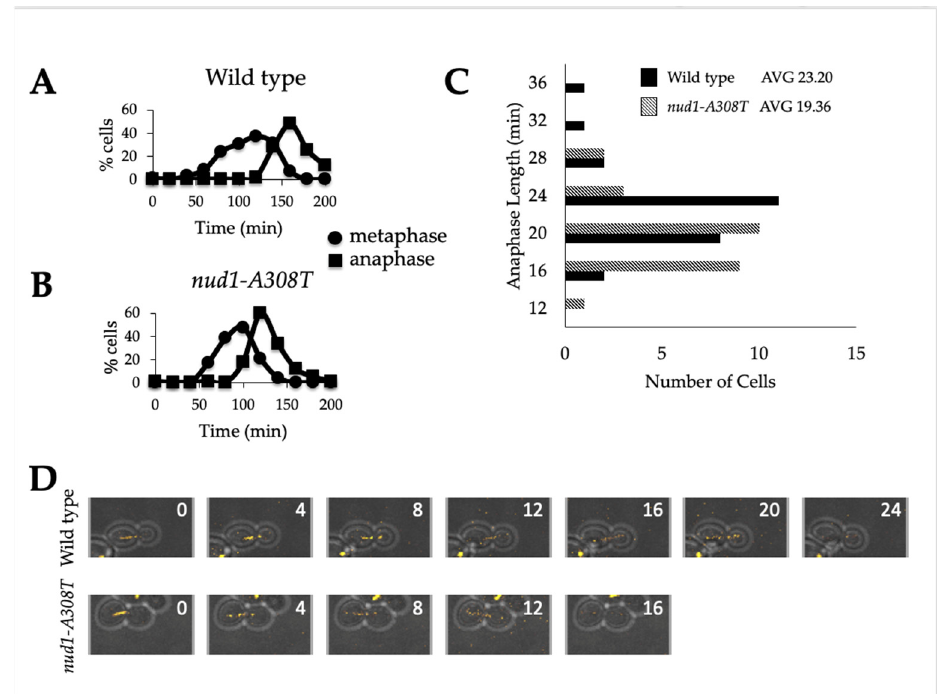
Figure 4. Mutants containing nud1-A308T have a shortened anaphase duration. ( A ) and ( B ): wild- type (AS138) and nud1-A308T (AS303) cells were grown to log phase and arrested in 5 ug/mL alpha-factor pheromone for 2.5 h. The cells were then released into medium lacking pheromone and samples were taken at the indicated times for tubulin immunofluorescence. The percentage of cells with metaphase (circles) or anaphase (squares) morphology in wild-type ( A ) and nud1-A308T ( B ) strains was quantified and plotted ( n = 100). ( C ) and ( D ): Wild-type (AS476) and nud1-A308T (AS477) cells harboring Tub1-mCherry and Dbf2-eGFP fusions were grown to log phase in SC + glucose medium and living cells growing on an agar pad were imaged every 4 min for a total of 4 h. ( C ) The start and completion of anaphase was marked and the number of cells with anaphase duration of 16, 20, 24, or 28 min in each strain was plotted ( n > 19). The average duration of anaphase in each strain is indicated above the graph. ( D ) A representative wild-type and nud1-A308T cell is shown.